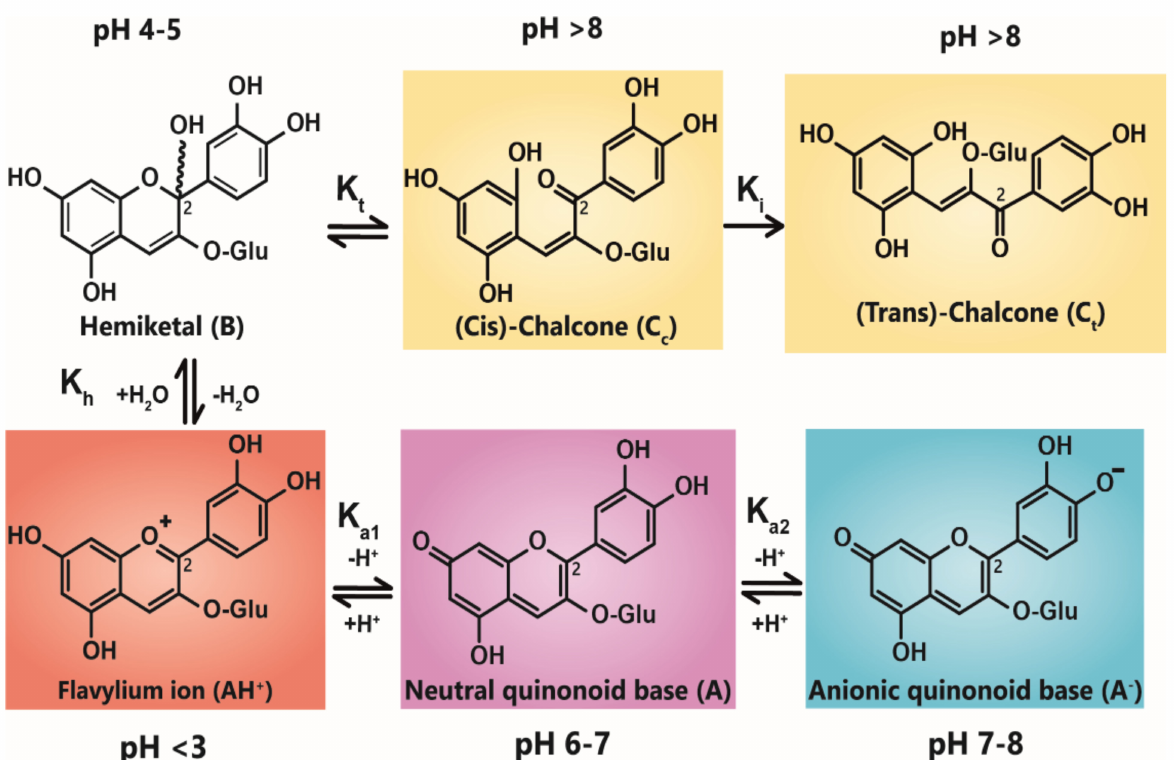
Figure 1. Structural transformation of cyanidin-3- O -glycoside as a function of pH. The three cyanidin species are given with their expected colours as outlined. Deprotonation from the C5-OH has been omitted for